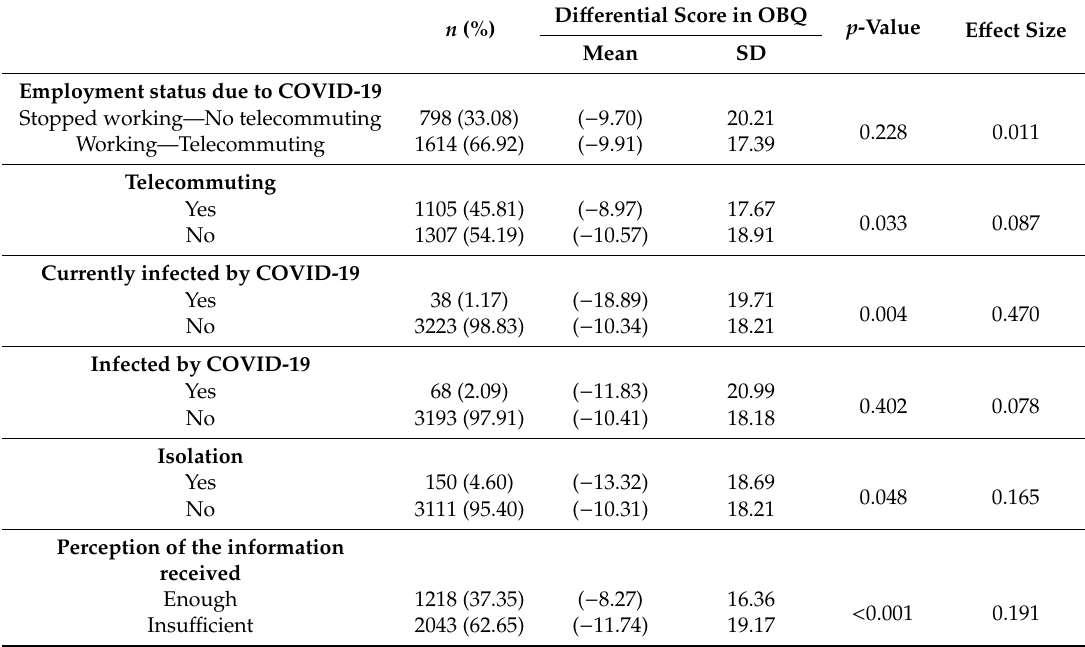
Table 3. Comparison of di ff erential scores in the OBQ according to COVID-19-related variables. n (%)